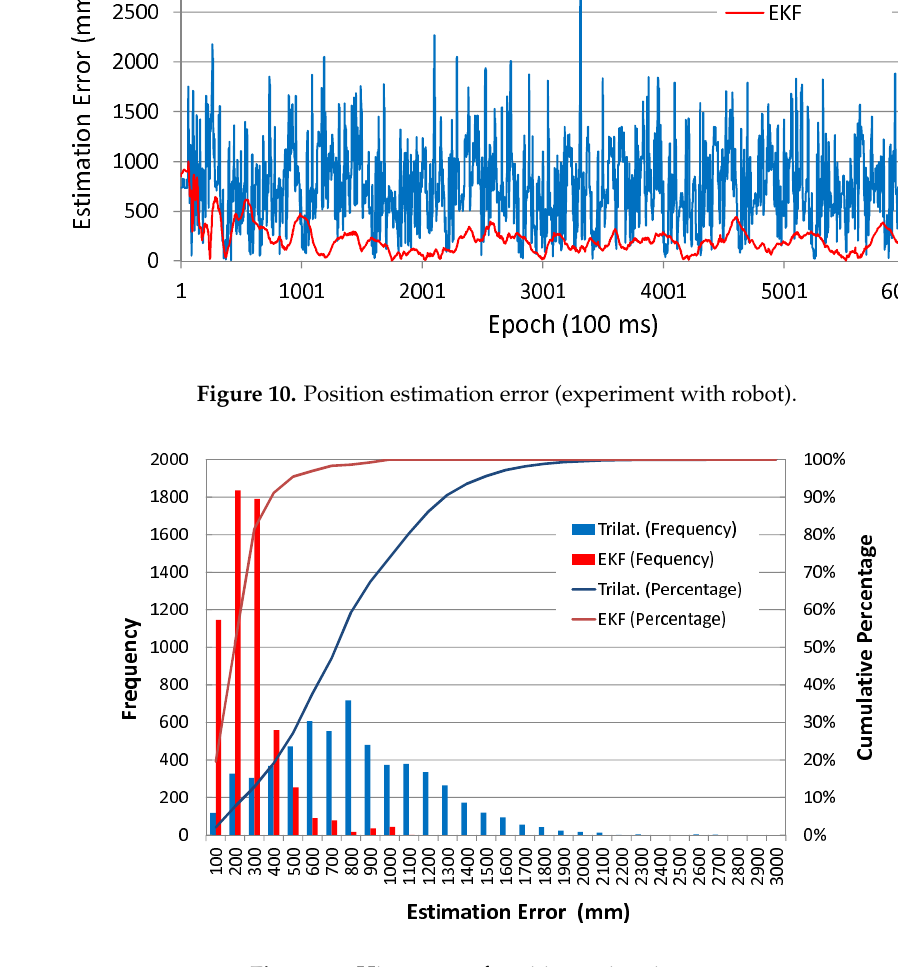
Figure 11. Histogram of position estimation error.